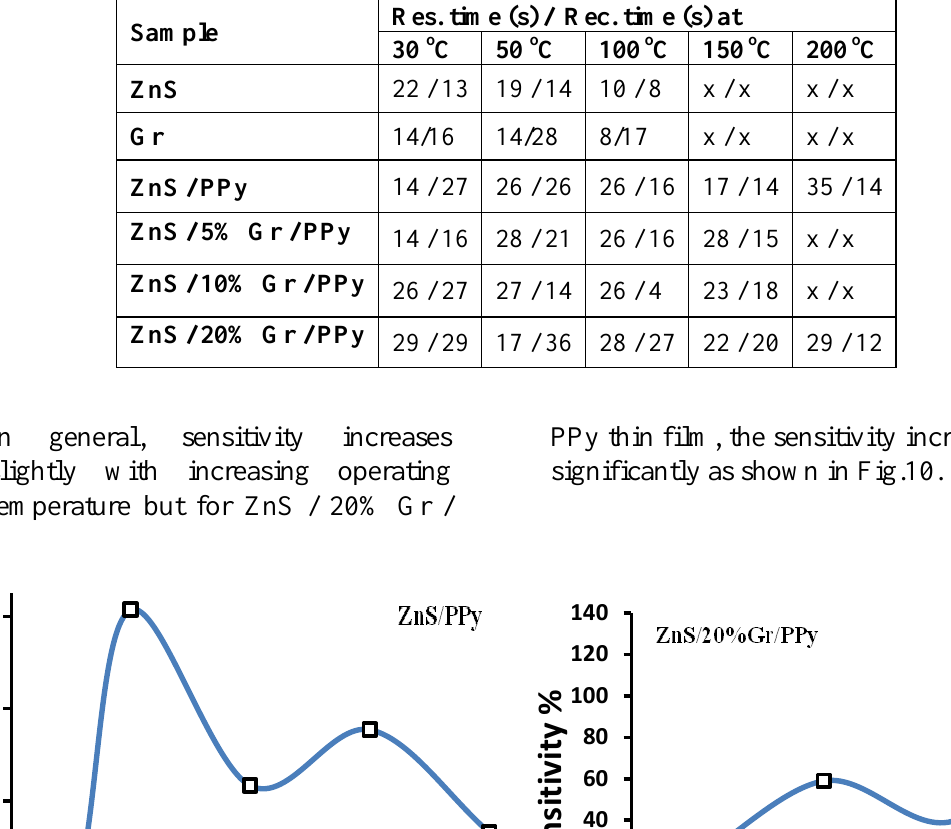
Table 4: Response time and recovery time of ZnS/Gr/PPy with different volume ratios of Gr against NO gas sensors. 2